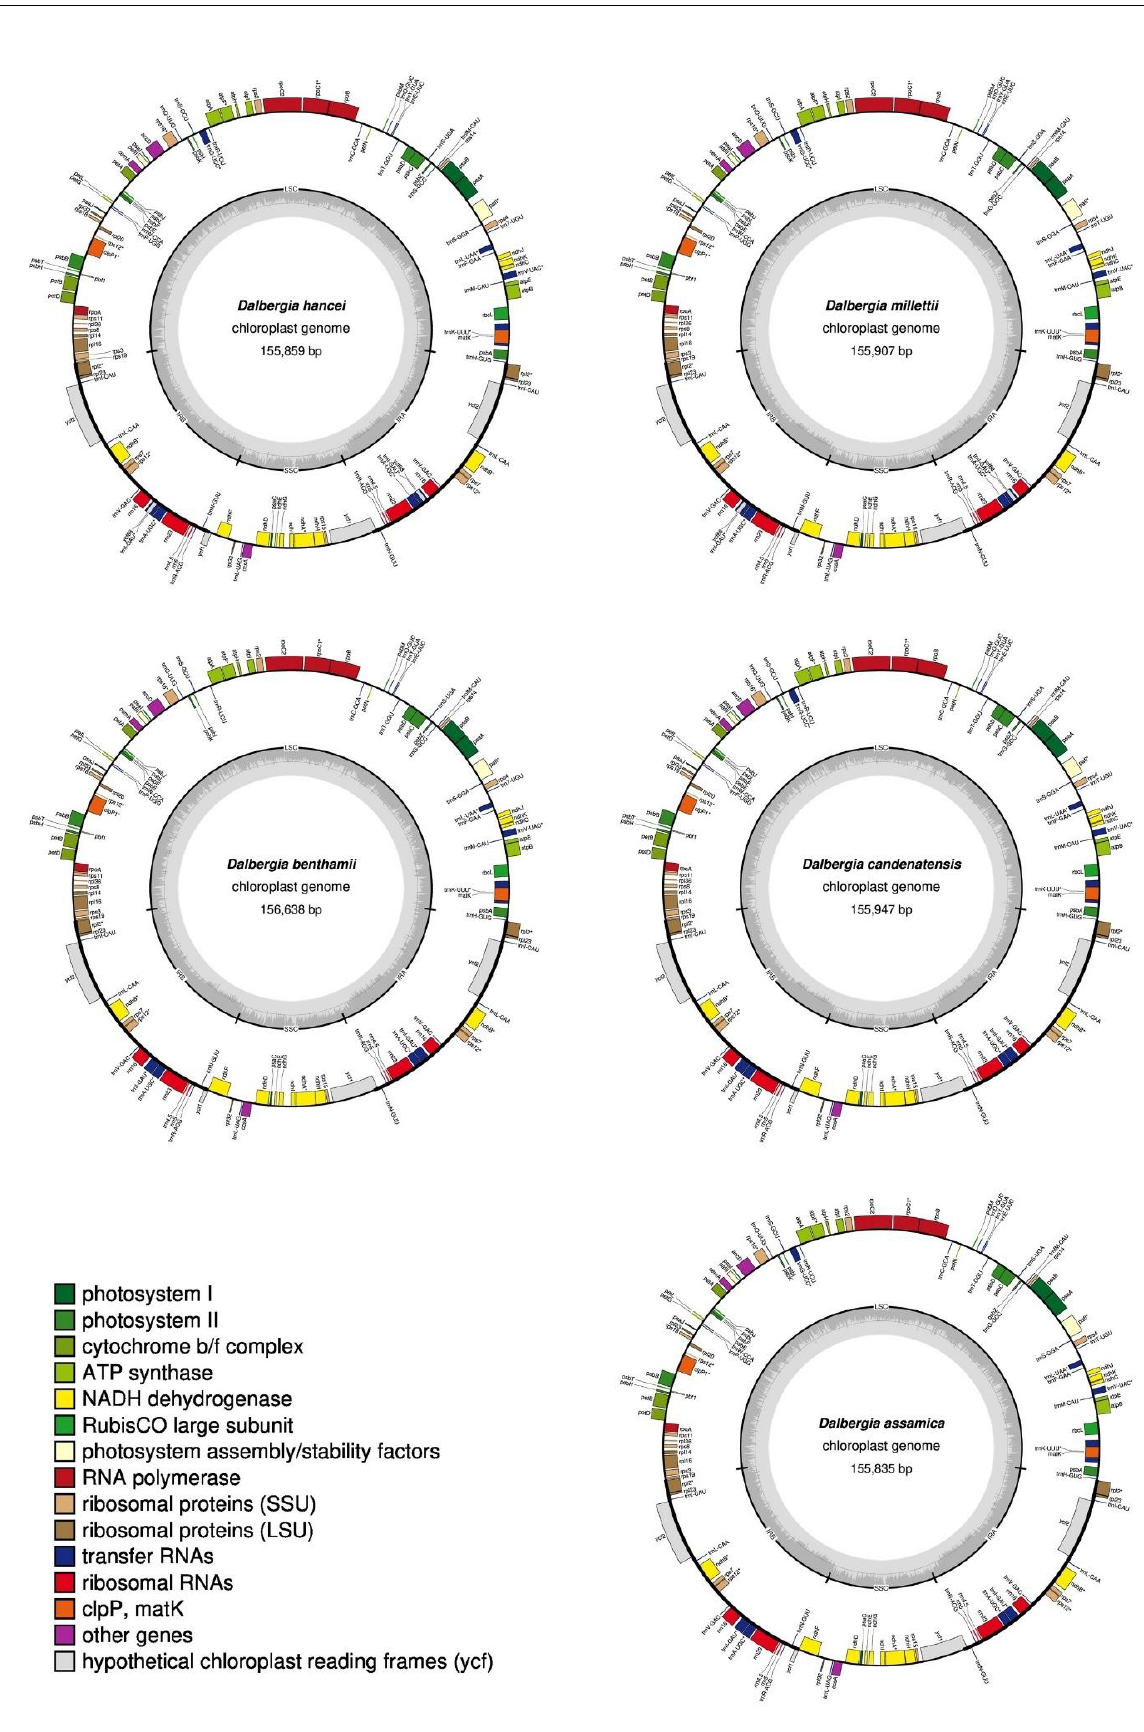
Figure 1. Genome maps of the five Dalbergia chloroplast genomes.